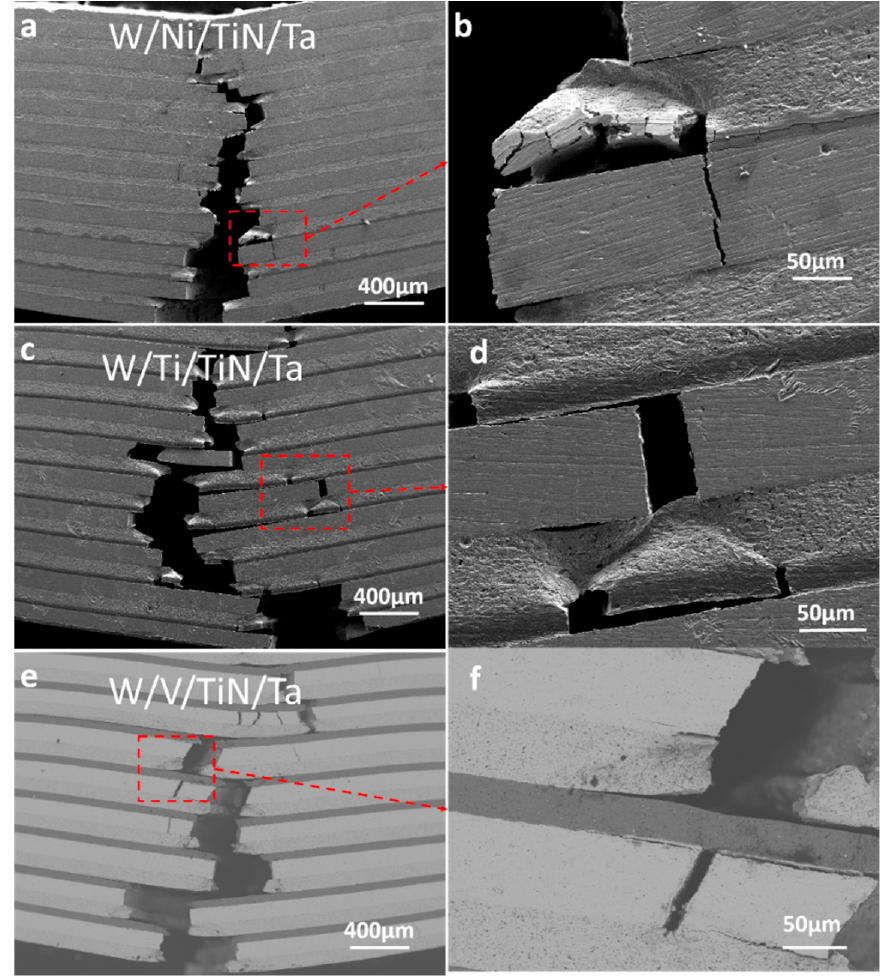
Figure 8. Three-point bending crack distribution of W/M/TiN/Ta-laminated composites with different transition metal layers joined at 1200 ◦ C: ( a , b ) W/Ni/TiN/Ta; ( c , d ) W/Ti/TiN/Ta; and ( e , f ) W/V/TiN/Ta.